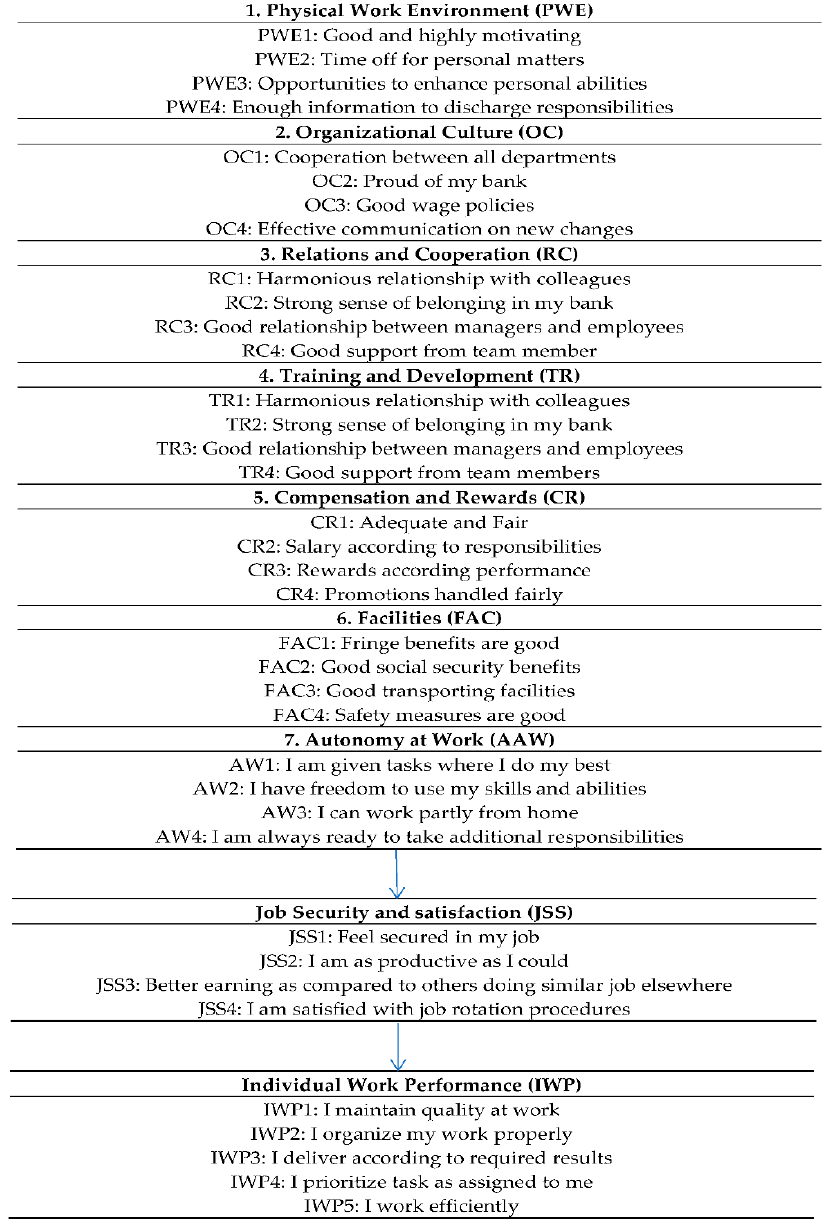
Figure 2. Dimensions and subdimensions of QWL, job satisfaction and individual work perfor-